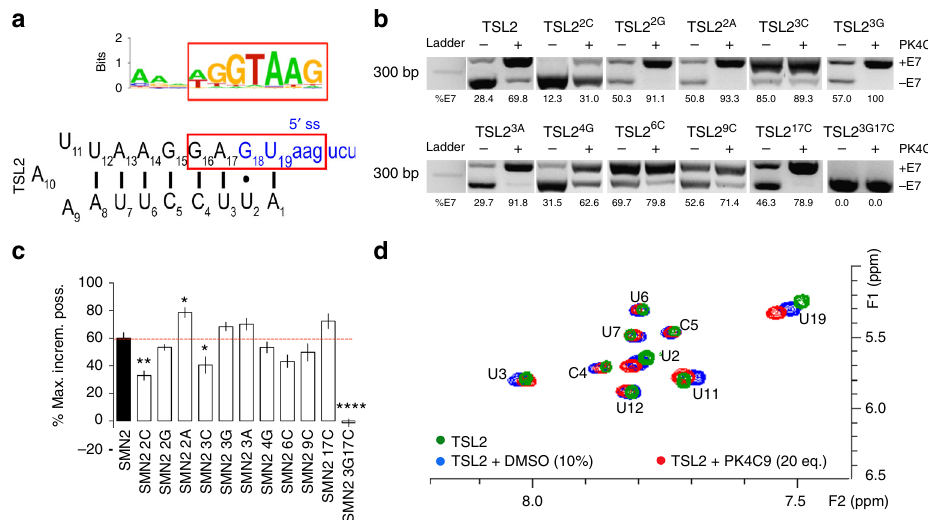
Fig. 5 PK4C9 binding to TSL2 affects the 5 ′ ss of E7. a Motif search from RNA-sequencing data ( n = 4 biological replicates), using algorithms Gibbs, MEME and Weeder, identi fi ed AGGTAAG as the most enriched motif in exons that are differentially spliced-in SMA cells upon treatment with PK4C9 (40 μ M, 24 h) compared to SMA cells treated with DMSO (24 h). The illustration shows the example found by Weeder and the similarity with TSL2 (red box). b RT- PCR from HeLa cells transfected with SMN2 E6 − to − 8 minigenes 16 carrying n.m. TSL2 or the indicated structural mutations. Transfected HeLa cells were treated with DMSO (0.04%, controls) or PK4C9 (40 μ M) ( n = 9; three biological and three technical replicates). c The effect of these mutations on PK4C9 activity was measured as the percentage of maximum E7 increment possible (see Eq. 2). d TOCSY NMR spectrum showing the cross-peak region of H5/H6 protons of the pyrimidine bases of TSL2 (40 – 50 μ M) with and without PK4C9 (20 equivalents). 1 H chemical shifts were referenced to the internal DMSO signal (2.63 ppm). Residues U2 and U19 showed the most signi fi cant chemical-shift perturbances. * p < 0.05, ** p < 0.01 and **** p < 0.0001. p -values were obtained by applying non-paired, two-tailed t tests with Welch corrections. The graph shows mean values ±